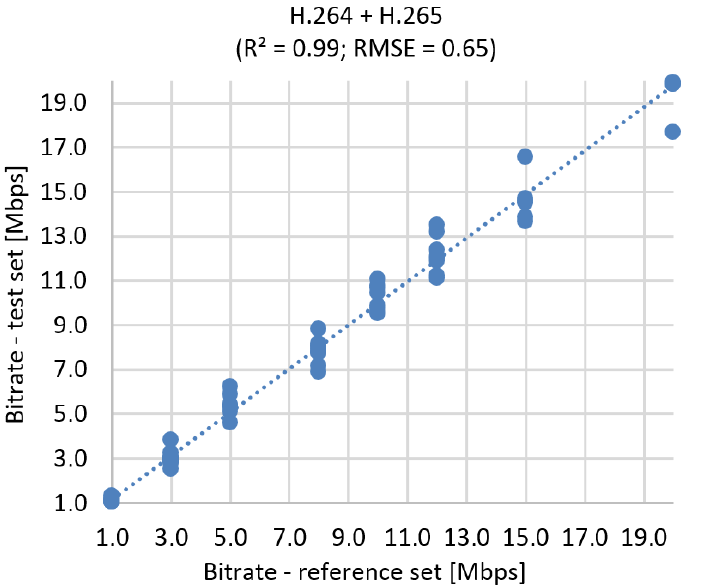
Figure 26. Correlation diagram for bitrate prediction based on MOS, Full HD + Ultra HD, H.264 +